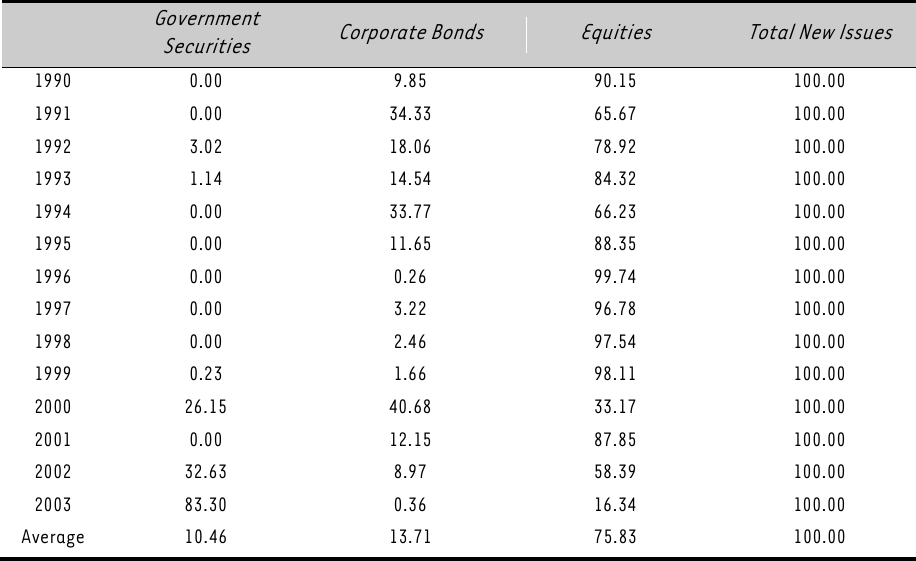
Summary of issue capital issues in the Nigerian capital